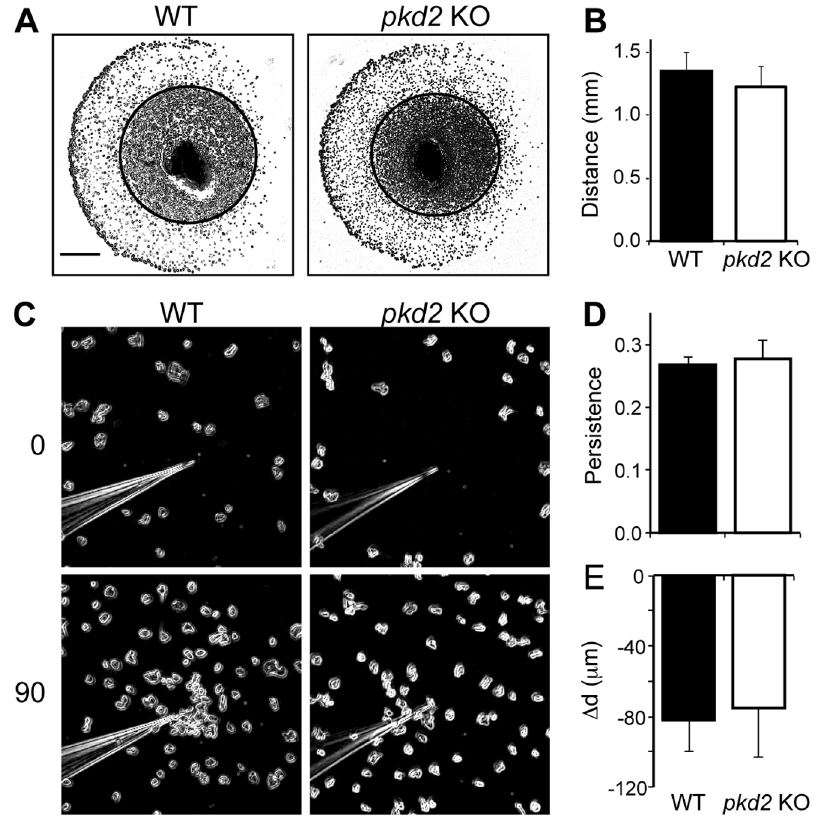
Figure 5. PKD2 is not essential for folate chemotaxis. A) Cells were deposited at the surface of buffered agar plates 4 mm away to a source of folate (to the left), and allowed to migrate for 5 h. Phase-contrast pictures of one representative experiment after migration are shown. The drawn inner circle represents the position of the cells at time 0. Scale bar: 1 mm. B) Distance travelled by the front of cells between times 0 and 5 h. WT and pkd2 KO cells moved towards folate with similar efficiency; n=4. C) WT and pkd2 KO cells submerged in phosphate buffer were allowed to move for 90 min towards a micropipette emitting folate. Phase-contrast pictures of one representative experiment are shown at times 0 and 90 min. D) In the experimental setup described in (C), persistence of cell movement was measured as the distance from the initial to the final cell position divided by the total travelled distance. No significant difference was observed between WT and pkd2 KO cells; n=4. E) The distance of each cell to the micropipette tip was measured at time 0 and 90 min to calculate the overall migration towards the source of folate ( D d). Negative values indicate that cells are moving towards the folate source. No significant difference was observed between WT and pkd2 KO cells; n=4.